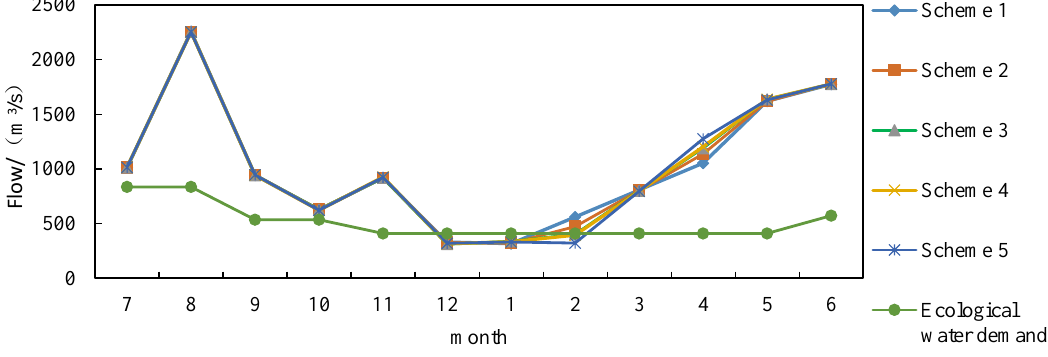
Figure 11. Comparative analysis of the outflow of Xiaolangdi in the normal year.